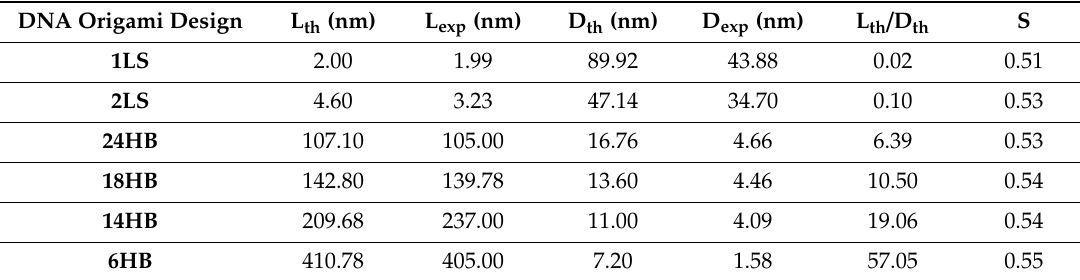
Table 1. Order parameter of DSCG samples doped with DNA origami nanoparticles exhibiting different aspect ratios. AFM and TEM images of these DNA origami nanostructures are displayed in Figure 1c,d,e,g,h,f, respectively.